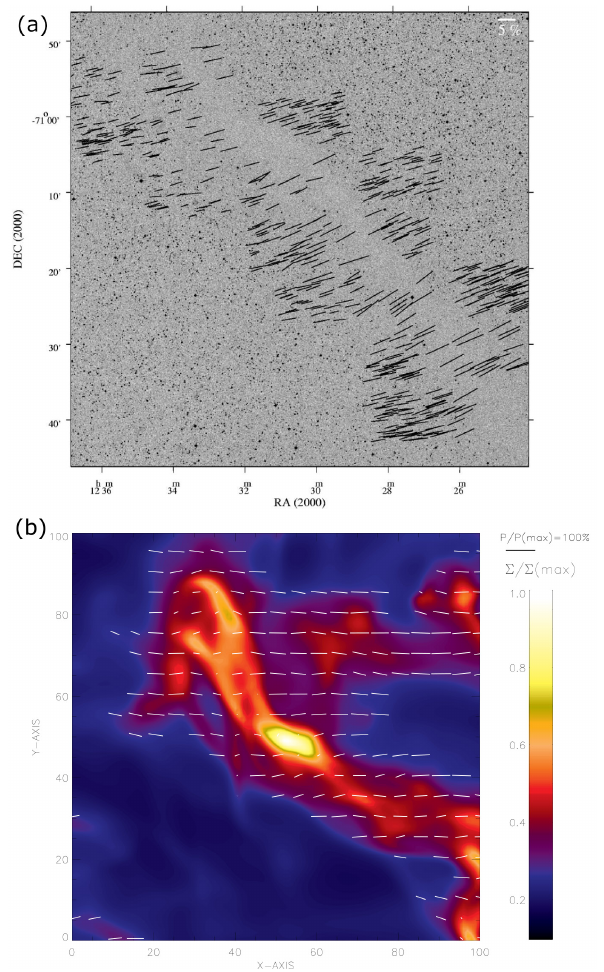
Fig. 5. Left panel: optical polarisation map of the Muska dark cloud (extracted from Pereyra and Magalhães, 2004). Right panel: simulated polarisation map from a three-dimensional simulation of MHD sub-Alfvénic turbulence (extracted from Falceta-Gonçalves et al.,